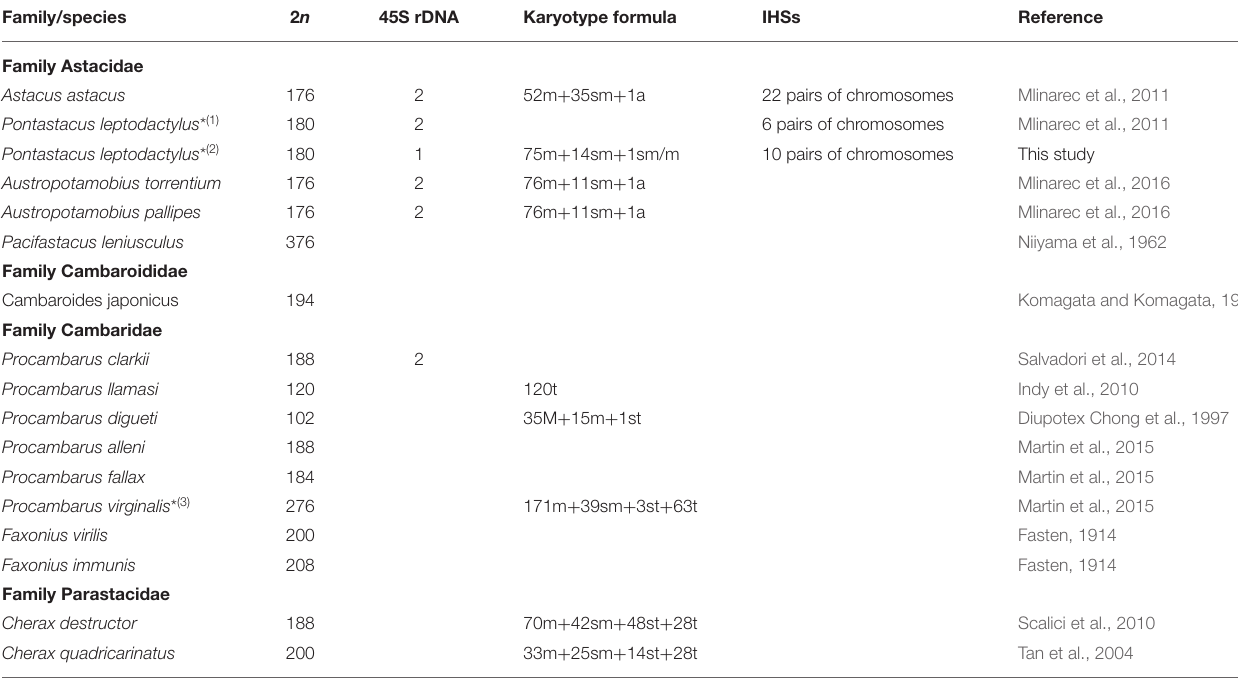
TABLE 1 | Chromosomal and cytogenetic characteristics of freshwater crayfish species of families Astacidae, Cambaridae, and Parastacidae.